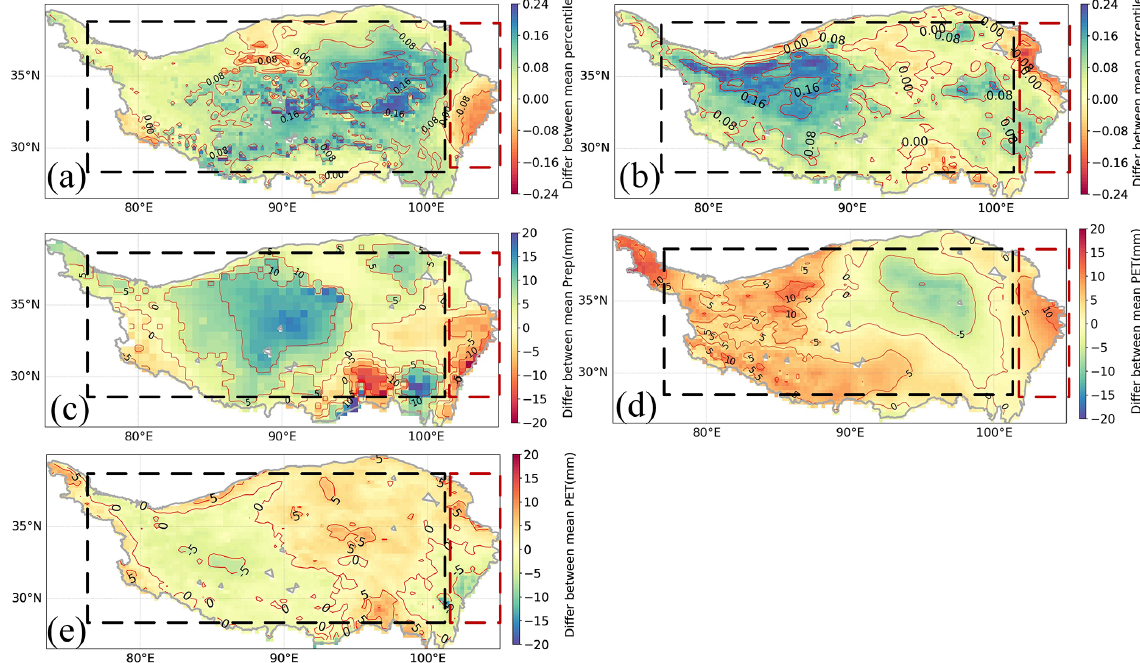
Figure 10. Difference (Differ) of the average state of the SM drought for (a) GLDAS and (b) ERA5, mean Prep (c) , and mean PET for (d) GLDAS and (e) ERA5 between the periods after and before the middle to late 1990s.